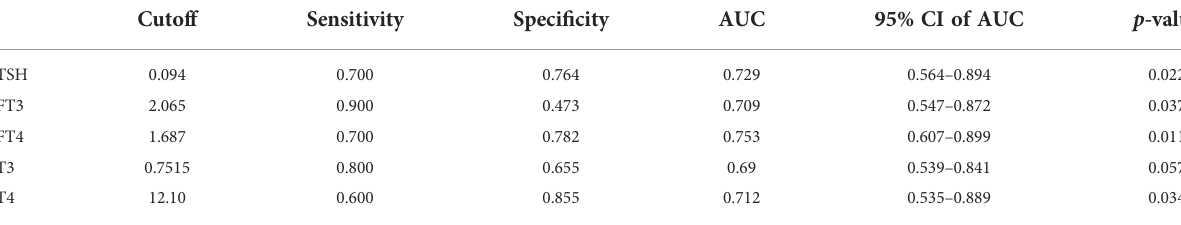
TABLE 5 Cutoffs of postsurgical thyroid hormones (within 1 week) to predict complete